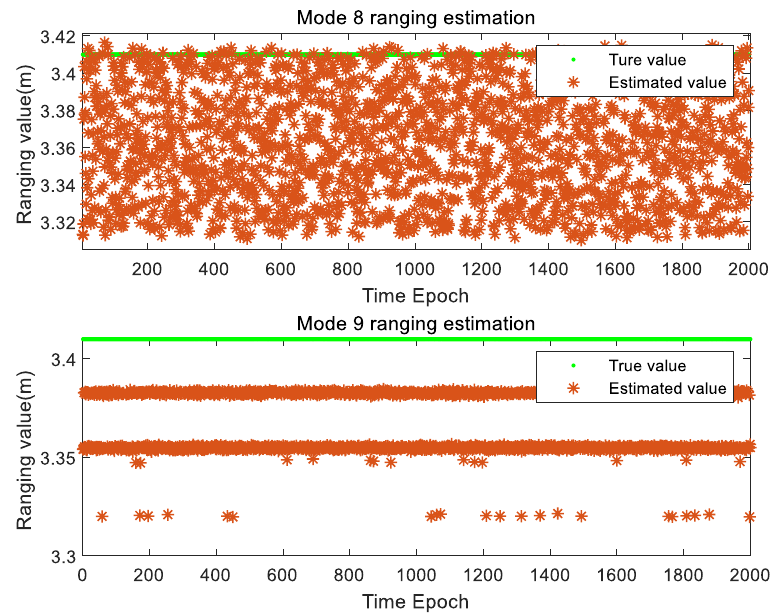
Figure 11. Ranging accuracy under different four-frequency combination modes.